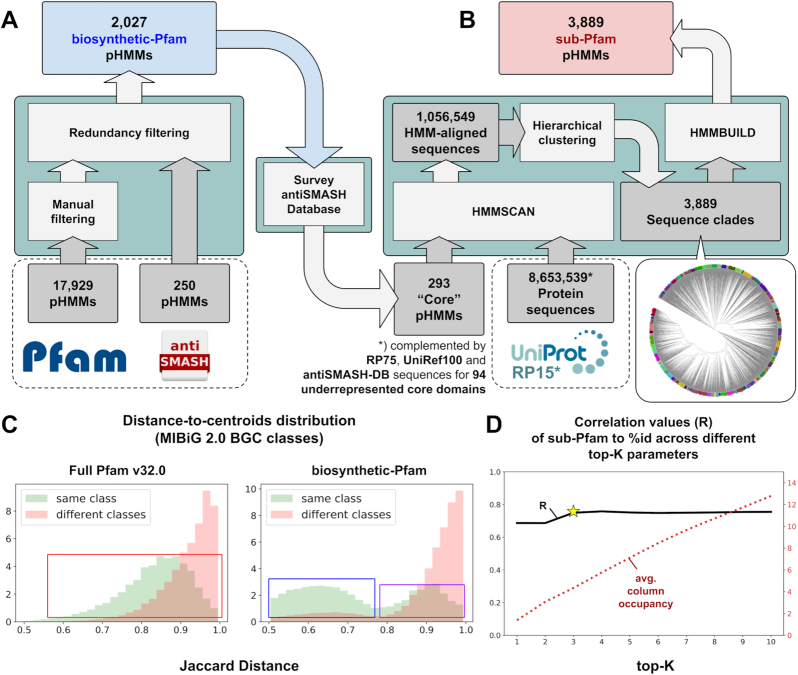

(A) Construction of biosynthetic-Pfam features and (B) sublevel Pfam (sub-Pfam) features. (C) Effect of Pfam model filtering on the discriminatory power of domain-presence Jaccard distance (JI index in BiG-SCAPE) measurements to separate MIBiG v2.0 generic classes (polyketide, NRP, RiPP, alkaloid, terpene, saccharide, other). It is shown that the filtering strategy will produce more clearly separated within-class distances (blue box) than the full Pfam counterparts (red box). The second mode at the right side of the biosynthetic-Pfam same-class distribution (purple box) largely stems from hybrid BGCs, containing signature domains of ≥2 distinct classes (e.g., NRPS-PKS, PKS-terpene-saccharide). (D) Pearson correlation values between protein sequence similarity (percent identity) and the corresponding sub-Pfam–based scoring in all AMP-binding domains (3,419 sequences, 879 BGCs) from the MIBiG v2.0 dataset across different top-K settings. Better correspondence (mean R = 0.75) is shown starting at top-K = 3 (BiG-SLiCE's default) onwards. The larger the top-K values, the more columns occupied (red dotted line) by the BGC's composite sub-Pfam features as opposed to the biosynthetic-Pfam features, which can be thought of as a way to “tune” the core domain's feature weight (akin to BiG-SCAPE's anchor boost setting).